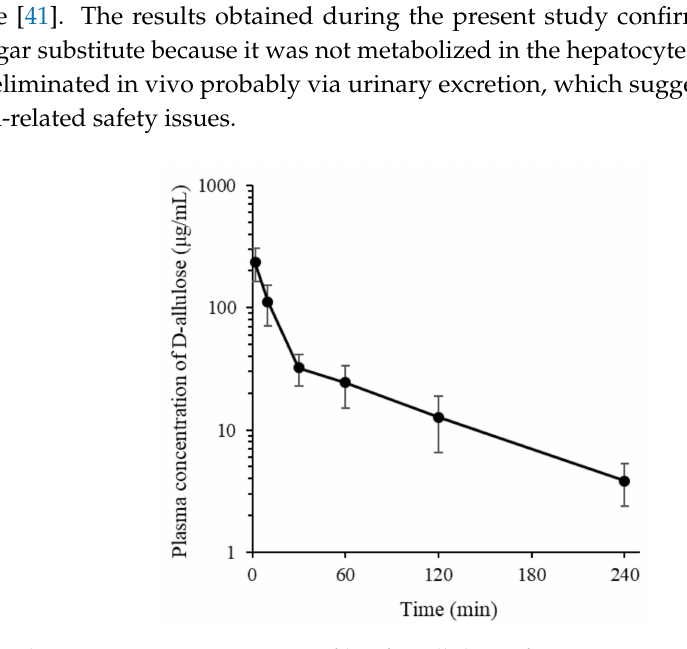
Figure 6. Plasma concentration-time profile of D-allulose after its intravenous administration at 100 mg / kg to rats ( n = 5). Results are presented as means and error bars represent standard deviation. Table 5. Summary of pharmacokinetic parameters of D-allulose after its intravenous administration at 100 mg / kg to rats (mean ± standard deviation, n =